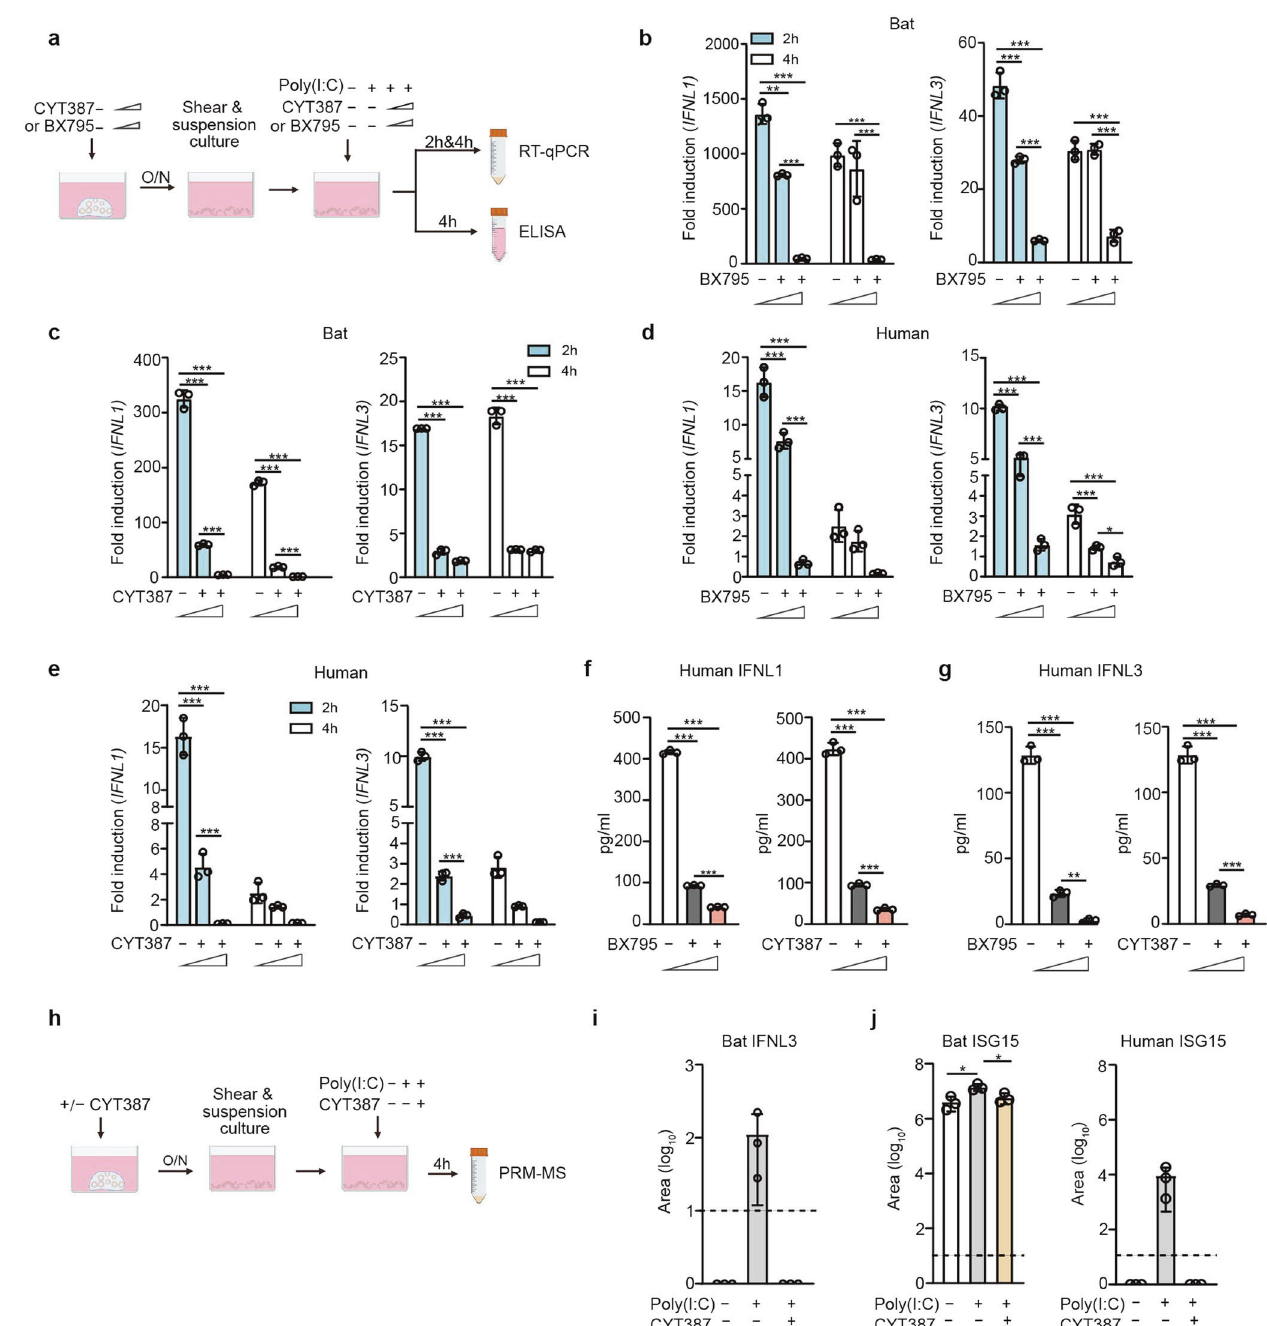
Fig. 3 TLR3 and RLR signaling pathways mediate antiviral responses in bat and human organoids. a A schematic graph outlines the experimental procedure for panels b – g . Bat and human intestinal organoids were pretreated with BX795 (0, 0.1 and 1 μ M) or CYT387 (0, 0.1, and 1 μ g/ml) overnight. After mechanical shearing, the organoids were incubated with or without 10 μ g/ml Poly(I:C), together with the initial concentrations of BX795 or CYT387. At the indicated hours after Poly(I:C) treatment, the organoids were harvested and subjected to RT-qPCR assay to examine mRNA expression levels of bat and human IFNL1 and IFNL3; cell-free media from human organoids were applied to ELISA to detect IFNL1 and IFNL3. Data represent the mean and s.d. of a representative experiment in organoids from a bat and human donor, n = 3. Ordinary one-way ANOVA with Tukey ’ s multiple comparison test. b , c Induction of IFNL1 (left) and IFNL3 (right) in bat intestinal organoids treated with BX795 ( b ) and CYT387 ( c ). Results show the fold change of GAPDH-normalized expression level in the Poly(I:C)-treated organoids relative to mock-treated organoids. d , e Induction of IFNL1 and IFNL3 in human intestinal organoids treated with BX795 ( d ) and CYT387 ( e ). IFNL1 ( f ) and IFNL3 ( g ) secretion from the human organoids at 4 h post-stimulation. h A schematic graph describes the experimental procedure for panels i and j . Bat and human intestinal organoids were pretreated with 1 μ g/ml CYT387 or DMSO overnight. After mechanical shearing, the organoids were incubated with 1 μ g/ml CYT387 or DMSO with or without 10 μ g/ml Poly(I:C) for 4 h. Cell-free media were then harvested and subjected to PRM-MS to analyze bat IFNL3 ( i ) and ISG15 of bat and human ( j ). The dotted lines represent the detection limit. Data represent the mean and s.d. of a representative experiment in organoids from a bat and human donor, n = 3. Two-tailed unpaired Student ’ s t test